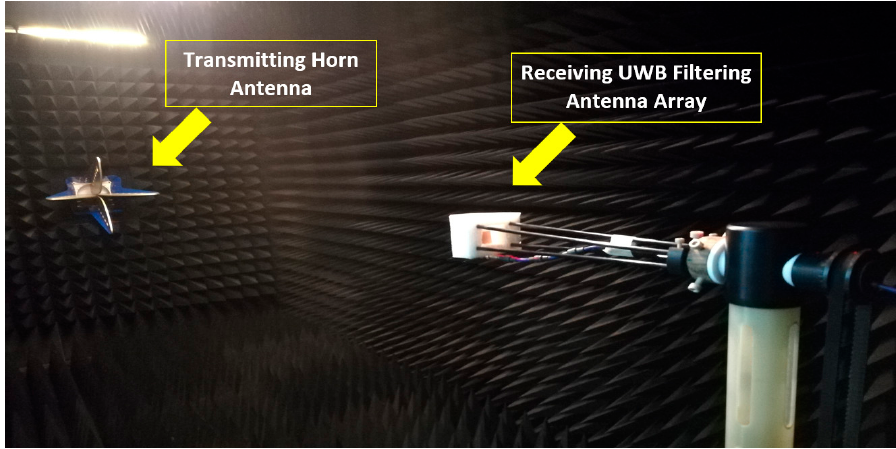
Figure 16. Radiation and gain measurement setup of UWB filtering antenna array.